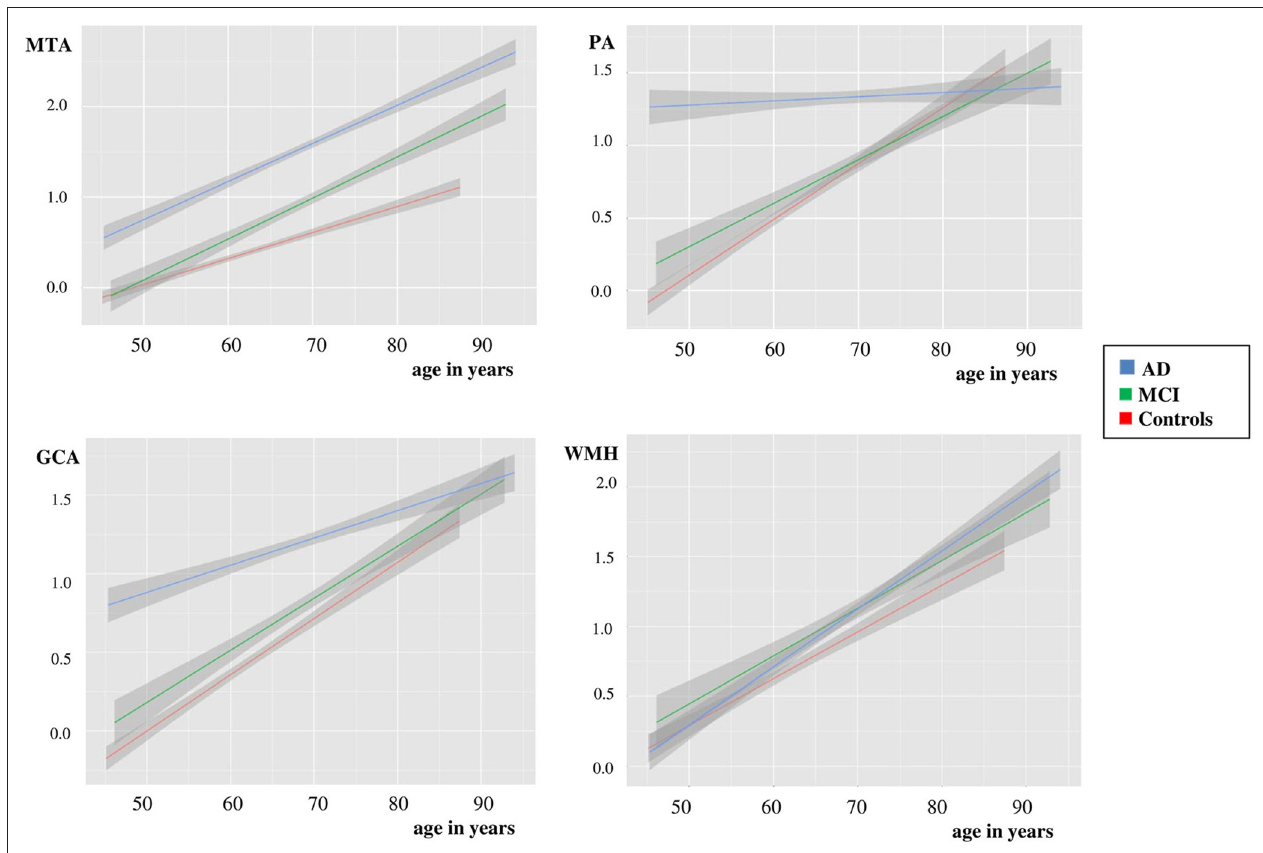
FIGURE 1 | Plots using linear regression analyses of MTA, PA, GCA, and WMH vs. age in controls, MCI and dementia due to AD, after correction for gender. Y-as: respectively mean MTA (left + right/2), PA (left + right/2), GCA, and WMH, X-as: age in years, 95% confidence interval is presented by the gray area on both sides of each